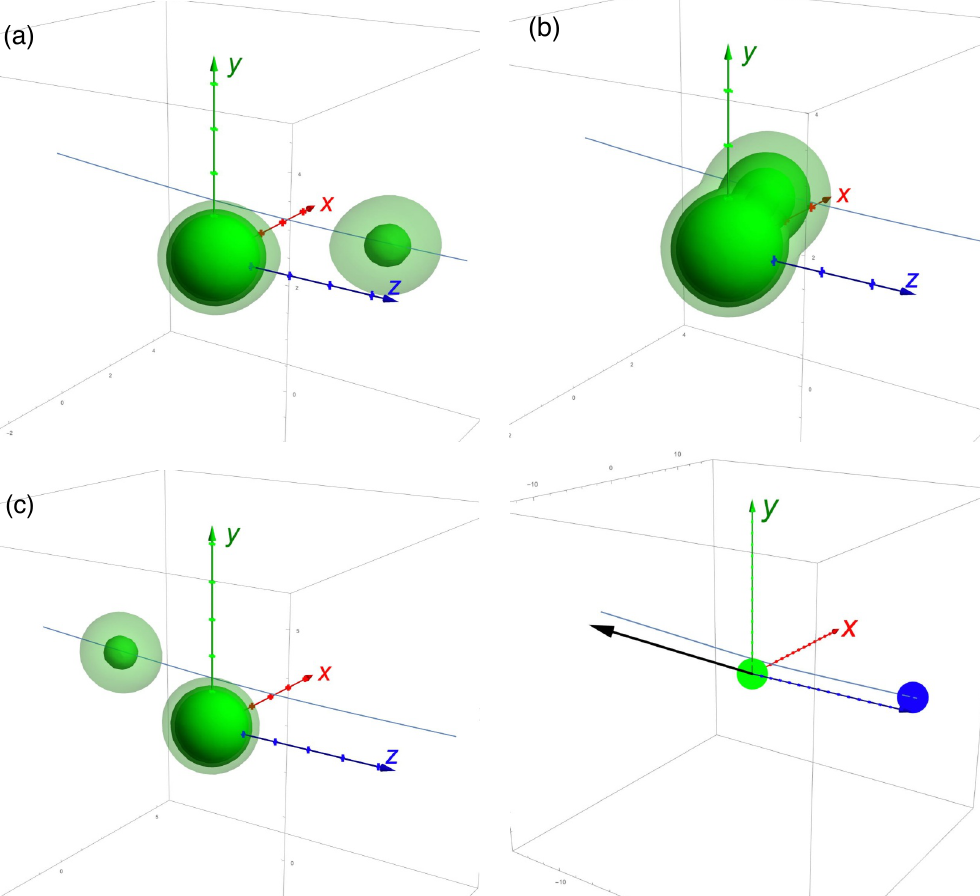
Figure 9 . Three frames from a scattering animation and a plot of the full trajectory with the with the outward direction ˆ n 0 indicated. The configuration has k = 2 , q = 1 , and C = 2 . The t out initial position and momentum are ~ R = (3 , 0 , 15) and ~ p = (0 , 0 , − 4) . The simulation runs for 8 0 0 time units and the three frames shown are at τ = 3 , 4 , 5 for (a), (b), (c) respectively. The outward direction has unit vector ˆ n 0 = ( − 0 . 52 , 0 . 30 , − 0 . 80) and is indicated by the black arrow in the last out panel. The outbound trajectory becomes parallel to this